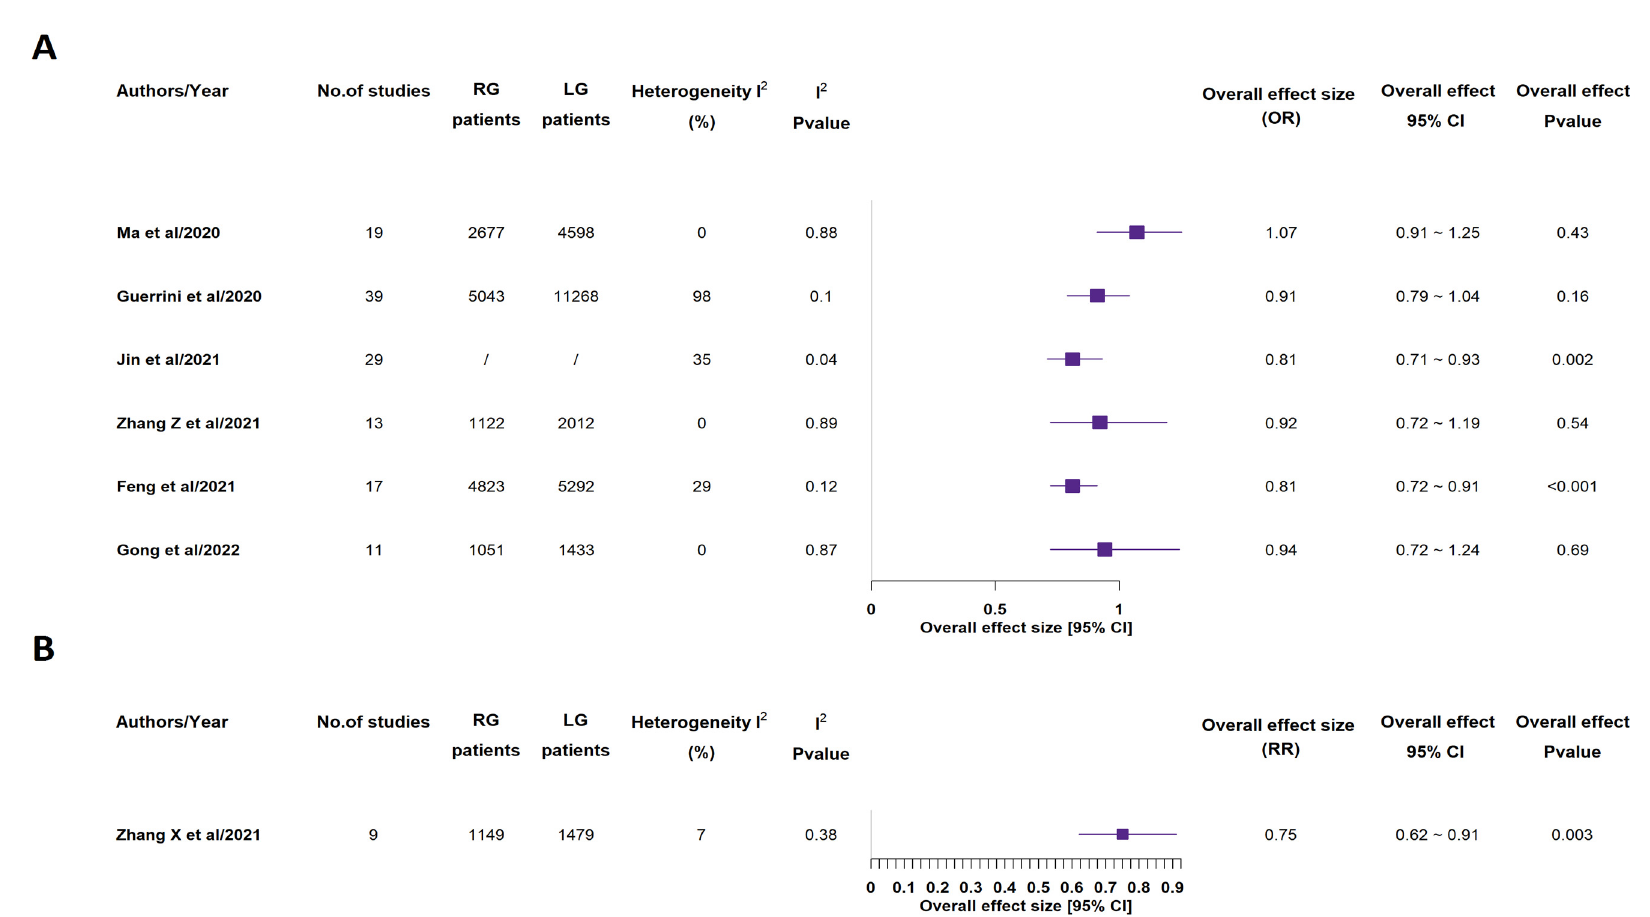
Figure 8. Overall complications rate. RG = Robotic gastrectomy; LG = Laparoscopic gastrectomy; OR = odds ratio ( A ); RR = risk ratio ( B )